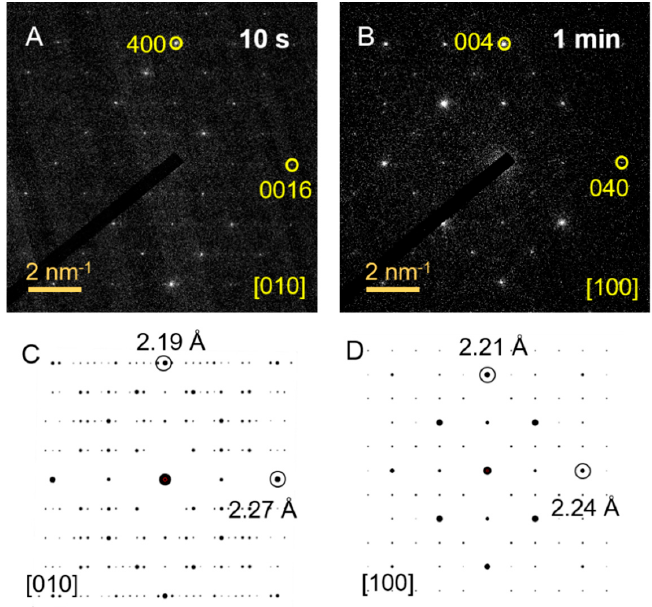
Figure 6. Low temperature structural evolution as electron irradiation accumulates. ( A ) Low magnification image of BA 2 FAPb 2 I 7 at liquid nitrogen temperature. ( B ) SAED pattern when the electron irradiation time is less than 1 min; the inset highlights the diffraction spot with satellite spots. ( C ) SAED pattern when the electron irradiation time is approximately 2 min; the inset highlights the diffraction spot without satellite spots. The electron dose-rate is approximately 0.05 e − Å − 2 s − 1 . ( D ) Room temperature structure in [100] projection. ( E ) Low temperature structure in [010] projection. ( F ) Schematic of the structure evolution.